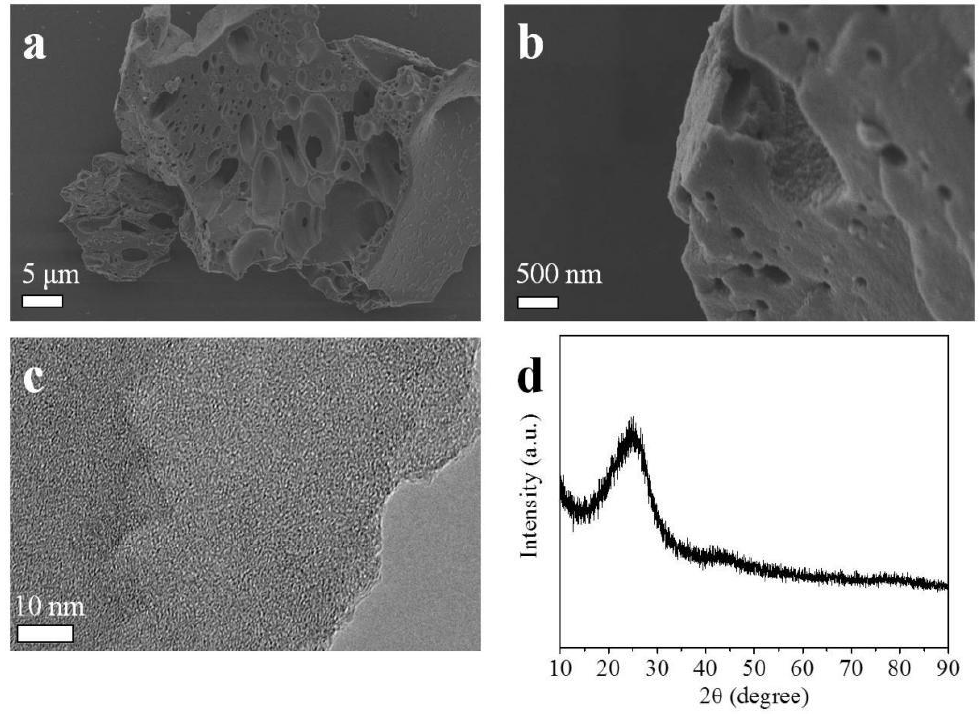
Figure 1. SEM images ( a , b ), TEM image ( c ) and XRD pattern ( d ) of UFK-600-0.2. Based on the elemental analysis results, these urea formaldehyde resin-derived Table 1. Porous textural, elemental compositions, and CO 2 uptakes of adsorbents derived from Urea formaldehyde resin under different